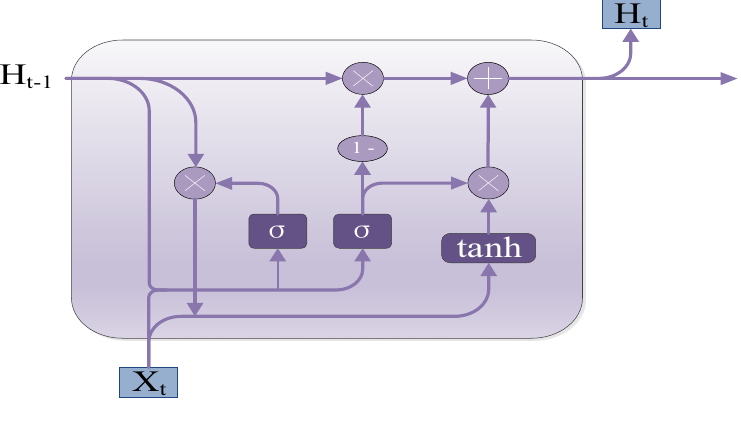
Figure 3. Structure of GRU cell.